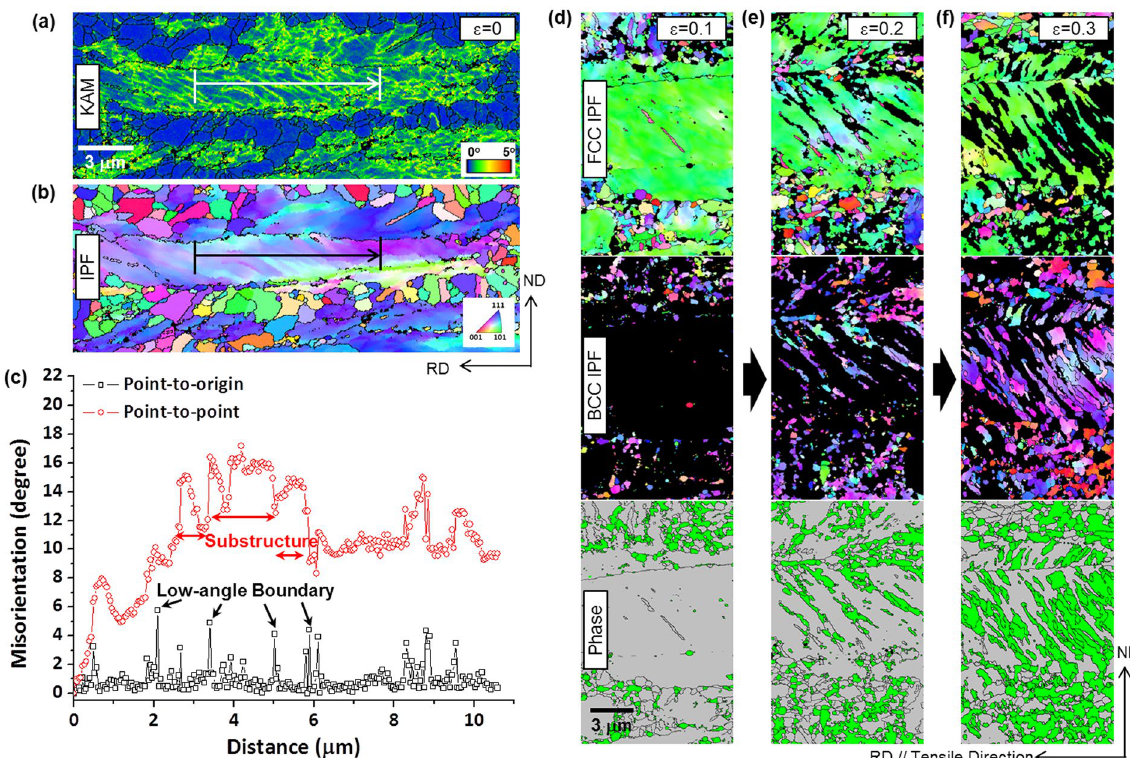
Figure 4. Substructure formation and TRIP behavior in non-recrystallized austenite. ( a–c ) EBSD KAM and IPF maps and misorientation profile data of the A700 steel before the tensile deformation. Substructures having low-angle boundaries are well developed. ( d–f ) IPF and phase maps of the areas deformed after the interrupted tensile test at true strains of 0.1, 0.2, and 0.3. Martensite is formed and grown at grain boundaries or along shear bands in non-recrystallized austenite grains.